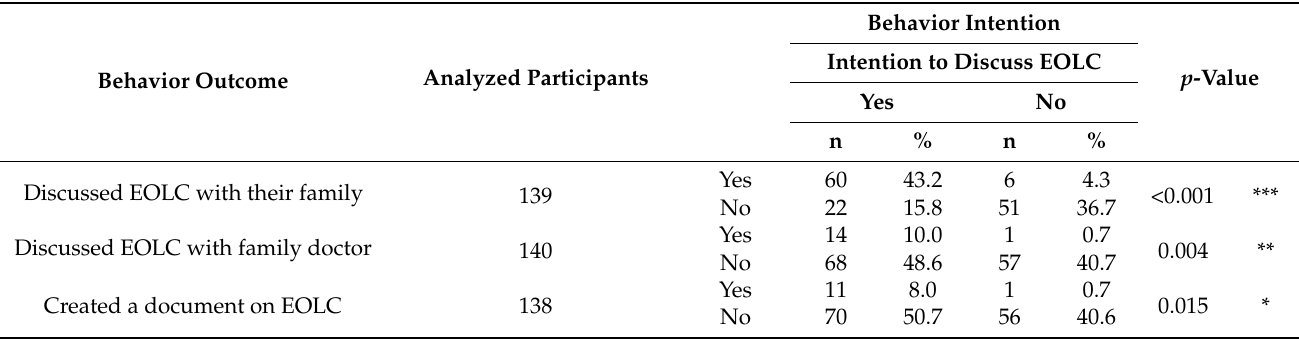
Table 3. The relationship between behavioral intention and behavioral outcome.